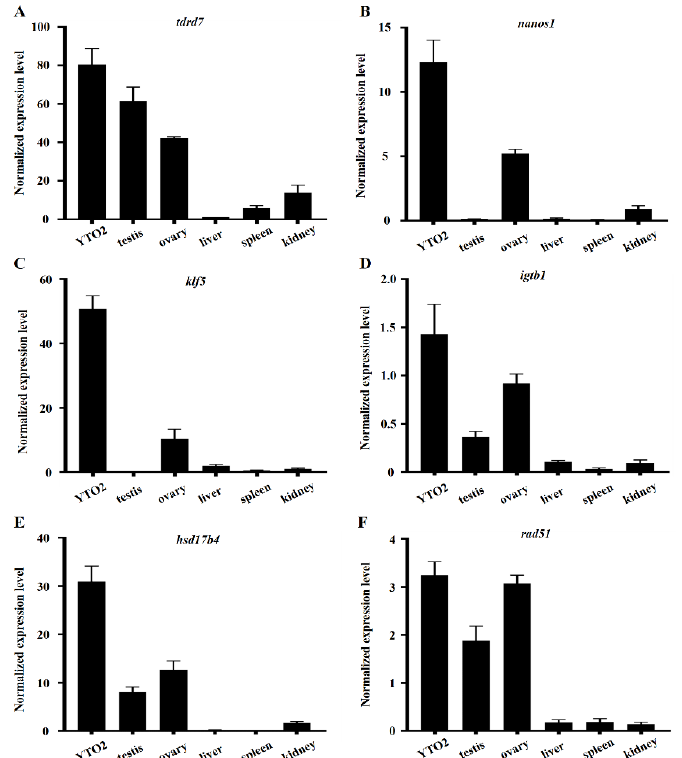
Figure 4. Expression level of germline marker genes in YTO2 cells and related tissues.